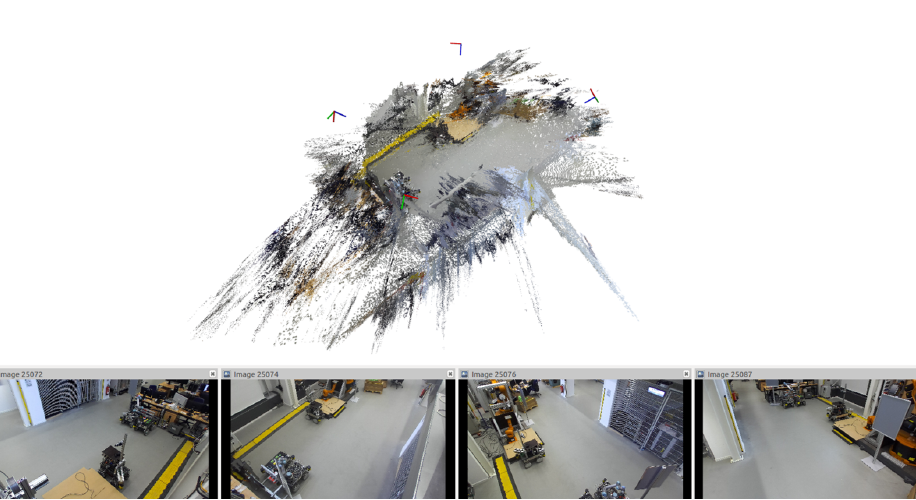
Figure 3. Calibrated point cloud of IGMR lab at 0.2 px cumulative calibration error; coordinate systems indicate camera